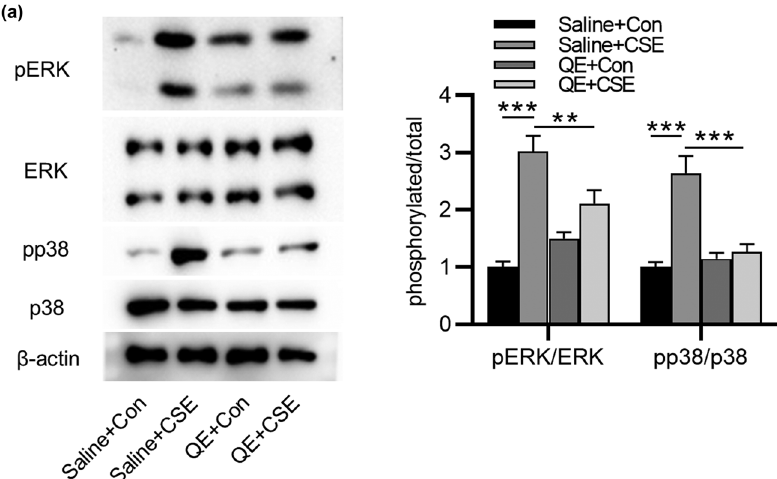
Figure 5: E ff ects of QE on the MAPK/ERK signaling pathway in CSE - treated HBECs. ( a ) Western blotting was performed to assess protein levels of ERK, p - ERK, p38, and p - p38 in HBECs in saline + Con group, saline + CSE group, QE + Con group, and QE + CSE group. ** p < 0.01 and *** p <